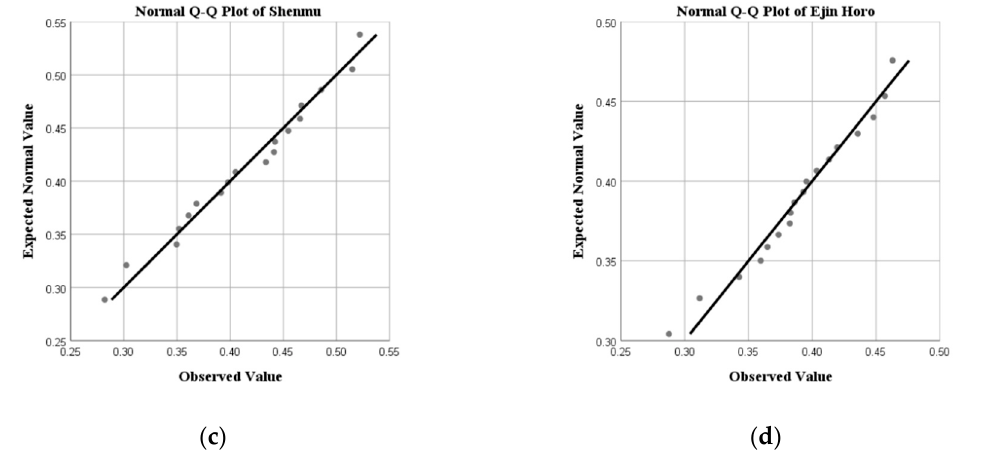
Figure 3. Normality of average VC in Shenmu County and Ejin Horo Banner. ( a ) is the normality of average VC data in Shenmu County from 2000 to 2017 and ( b ) is the normality of average VC data in Ejin Horo from 2000 to 2017. ( c ) and ( d ) show the normal QQ plot (Quantile-Quantile Plot) of the average VC data in Shenmu County and Ejin Horo from 2000 to 2017.